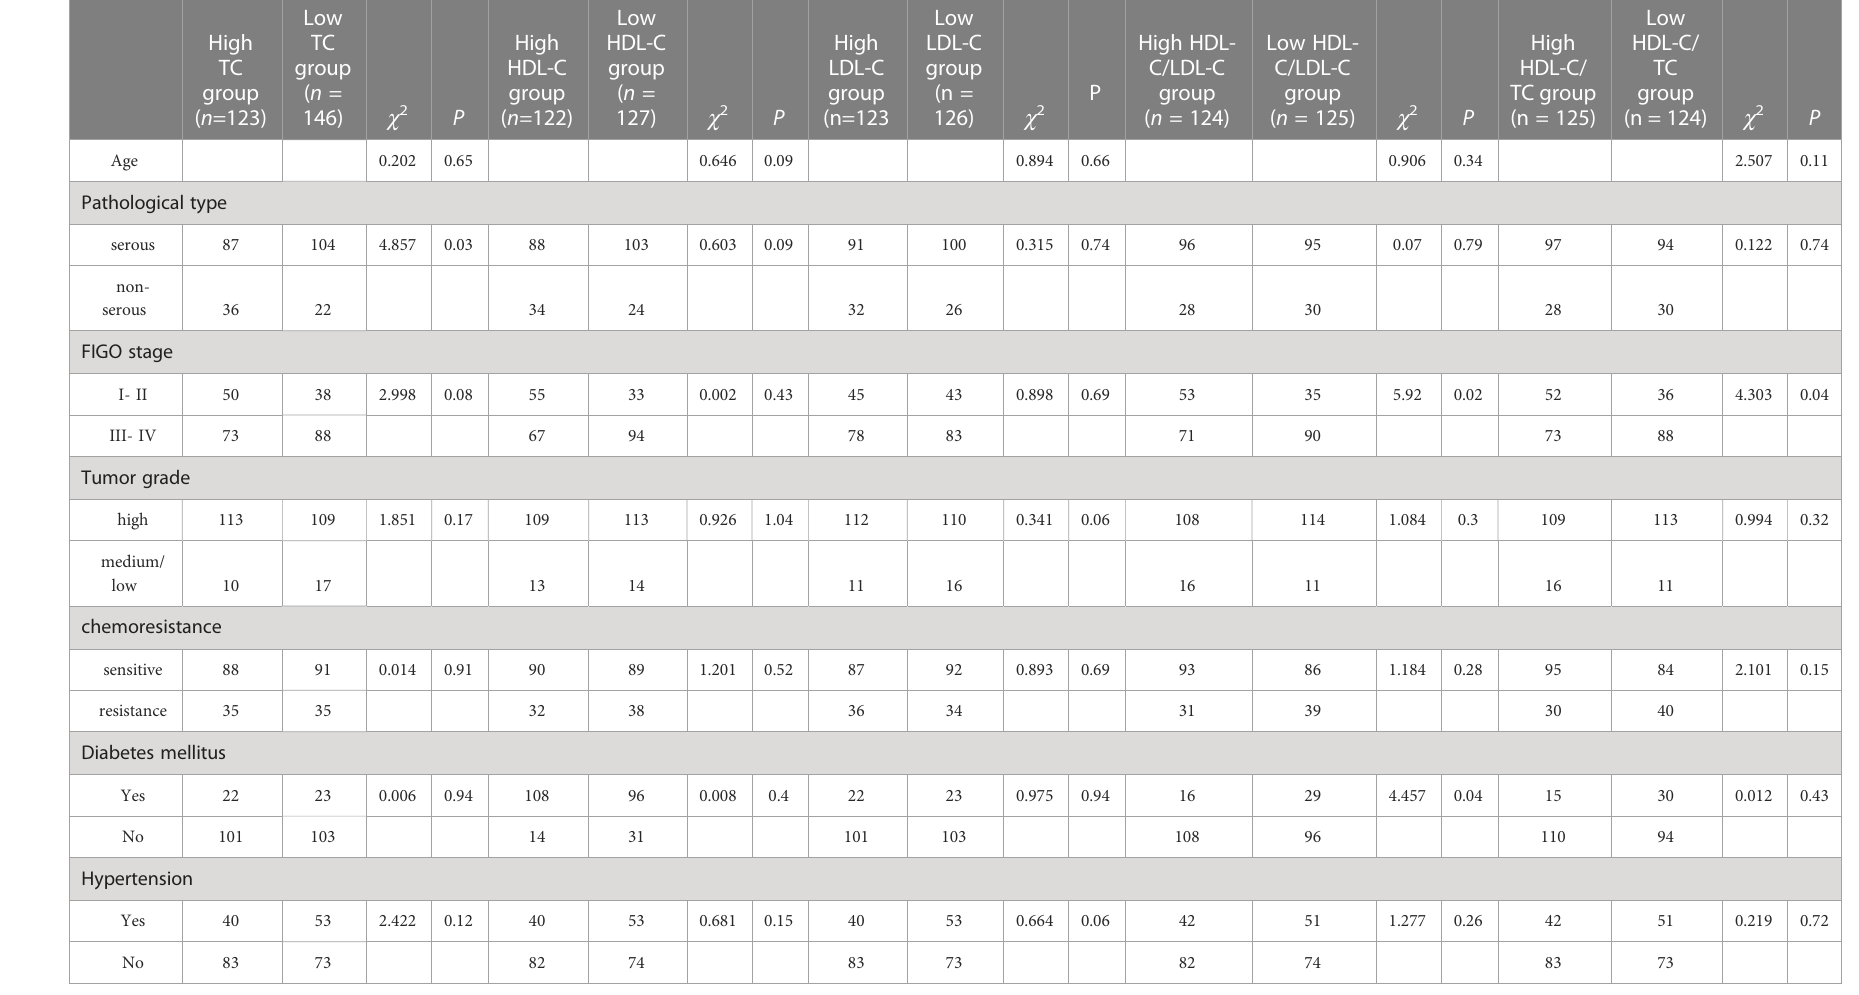
TABLE 1 Correction between clinicopathological features and different lipid level groups of 249 EOC